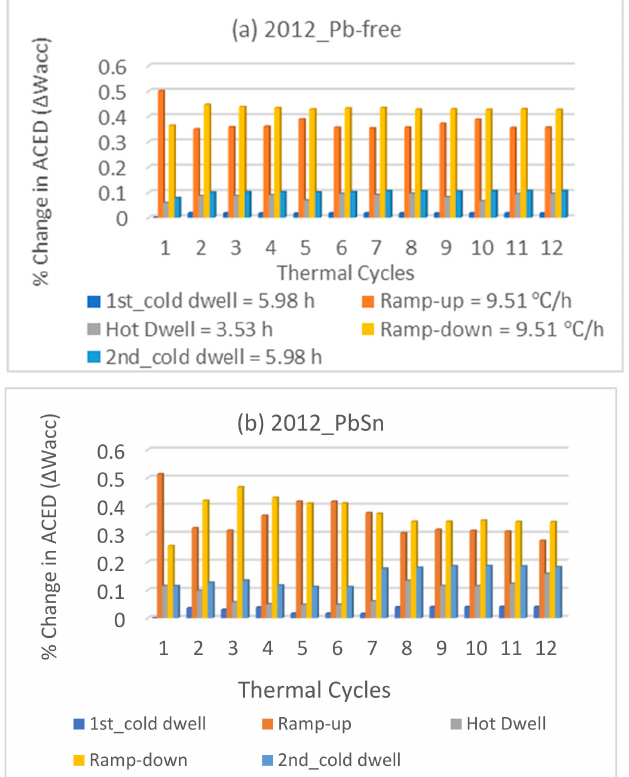
Figure 6. Change in ACED distribution from TRA thermal cycle for: ( a ) Pb-free, ( b ) PbSn intercon- nects.